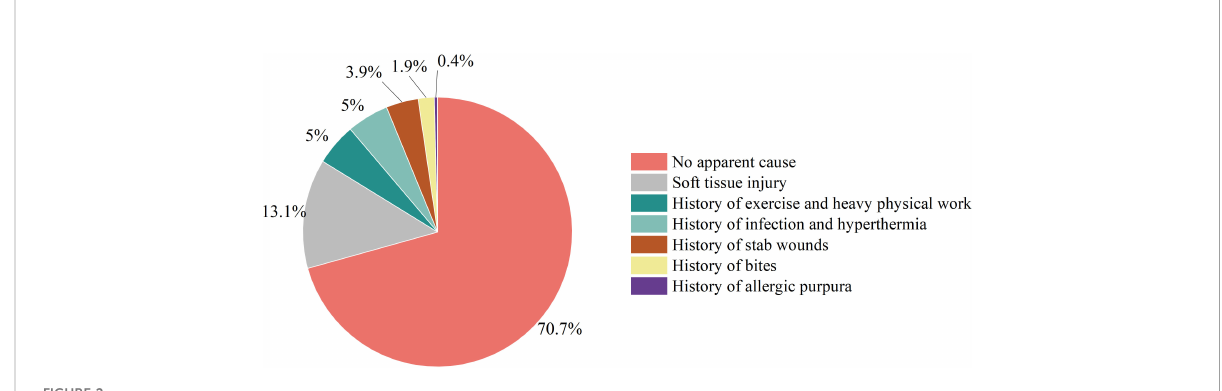
FIGURE 2 Etiology distribution chart.